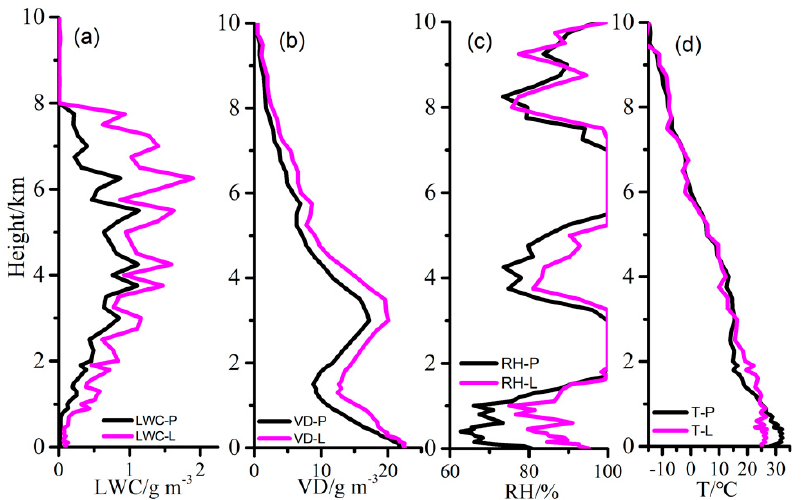
Figure 10. Same as Figure 9 but for Case 2 (Precipitation peak at 1000 LT and the maximum number of CG flashes at 1930 LT on 6 July 2013). The vertical profiles of liquid water content (LWC) ( a ), vapor density (VD) ( b ), relative humidity (RH) ( c ), and temperature (T) ( d ).